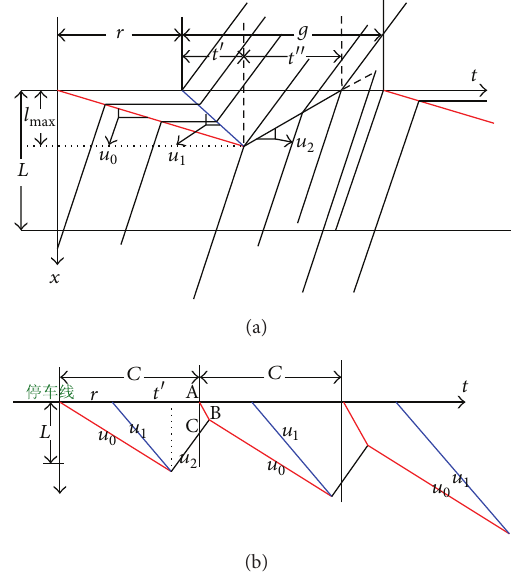
Figure 4: Traffic wave